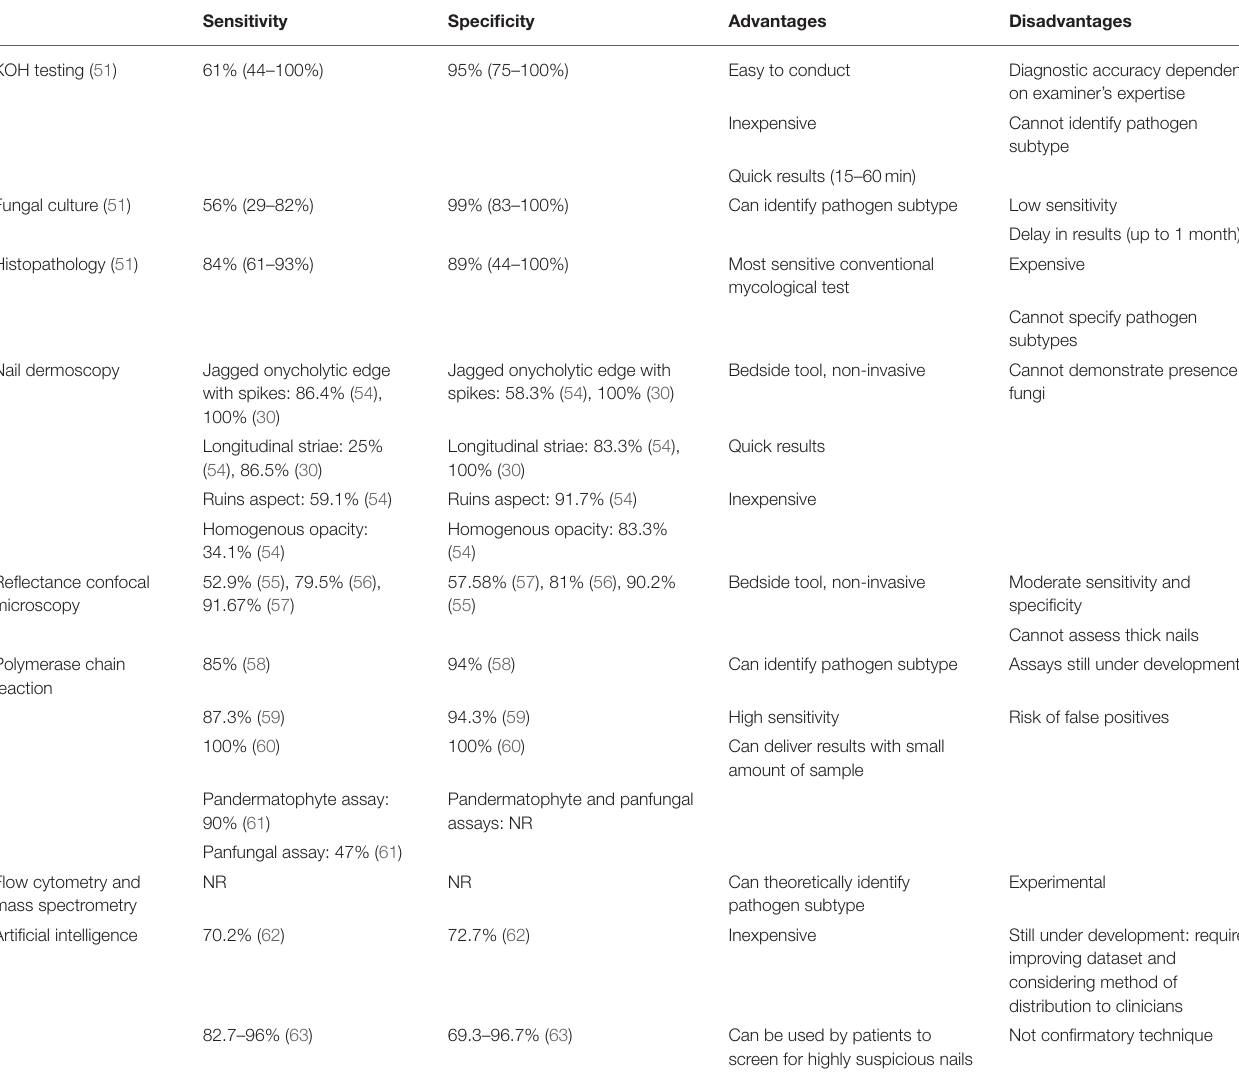
TABLE 1 | Summary of diagnostic techniques for